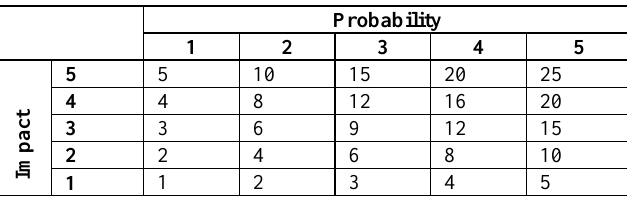
Table 1. Pitfall assessment matrix using numerical scales (based on Cox, 2008:502; Project Management Institute,